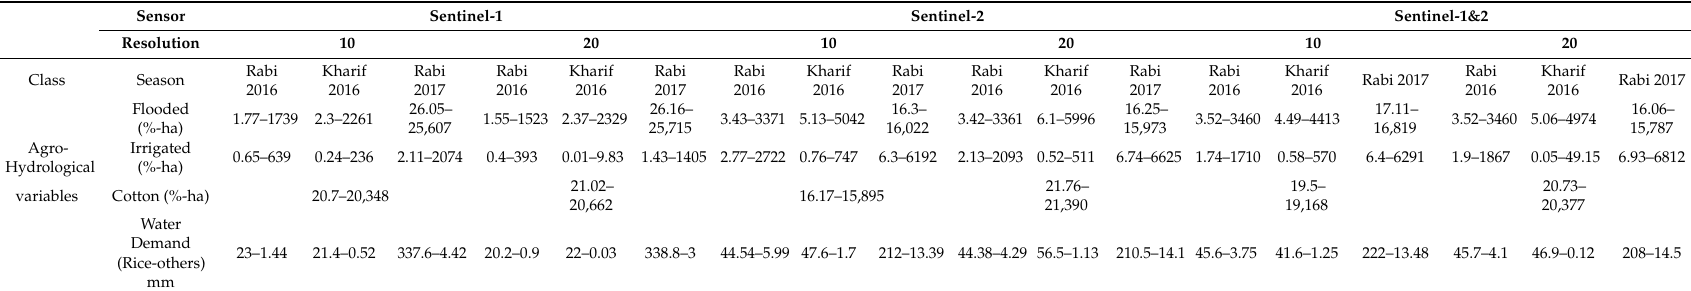
Table 4. Areas of irrigated and flooded crops and corresponding Irrigated Water Demand (IWD). Crop areas are expressed both in % of the total watershed area and in ha. IWD are expressed in mm/season, the corresponding water total over the watershed area. This total should be compared to rainfall, runoff, and amount of aquifer recharge, also expressed in